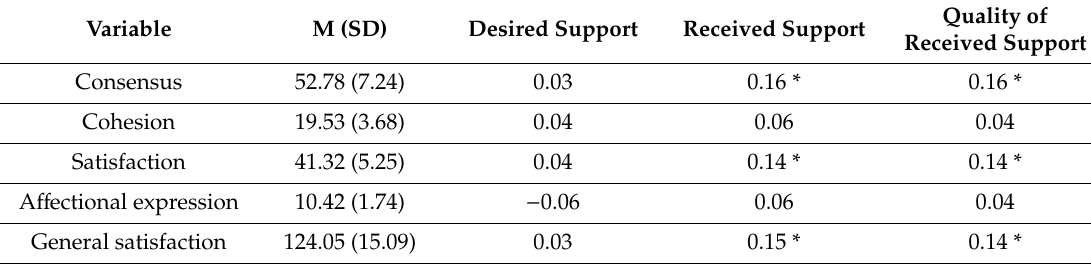
Table 2. Pearson’s linear correlation coe ffi cient for a relationship satisfaction and its components with social support.